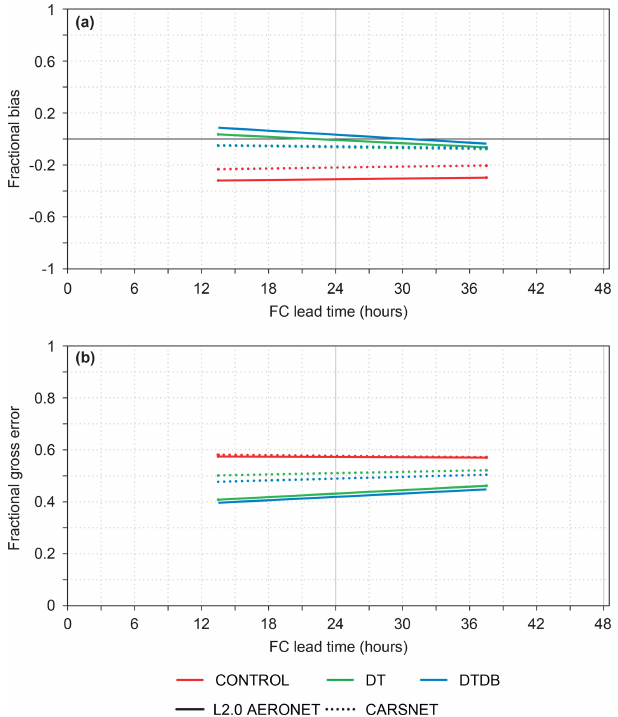
Figure 9. Fractional bias (a) and fractional gross error (b) as a function of forecast range for experiment CONTROL (red), exper- iment DT (green) and experiment DTDB (blue). Data are averaged over central–northern China (30–45 ◦ N, 75–135 ◦ E) for the period March–May